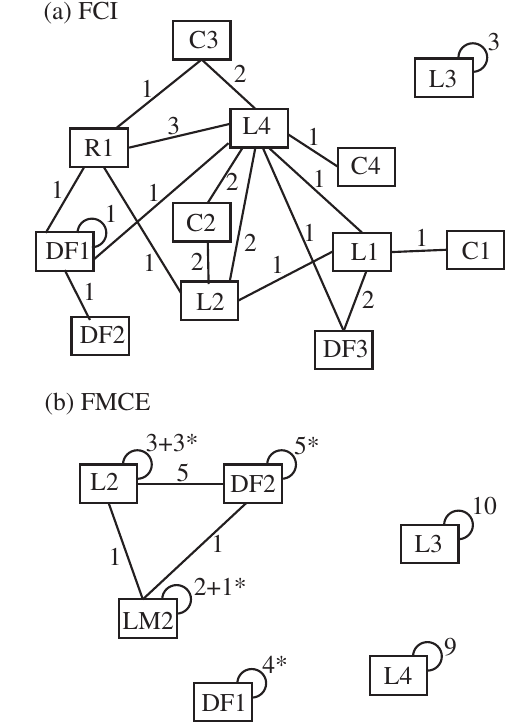
FIG. 2. Comparison of the network of principles of the (a) FCI and the (b) FMCE. The nodes represent principles, edges represent how many times two principles are used in the same item. The number near the curve connecting the same node represents the number of times the principle is the only principle for that item. For the FMCE, the number with a star represents the number of items using only the principle with reasoning step RS1 (reading a graph).